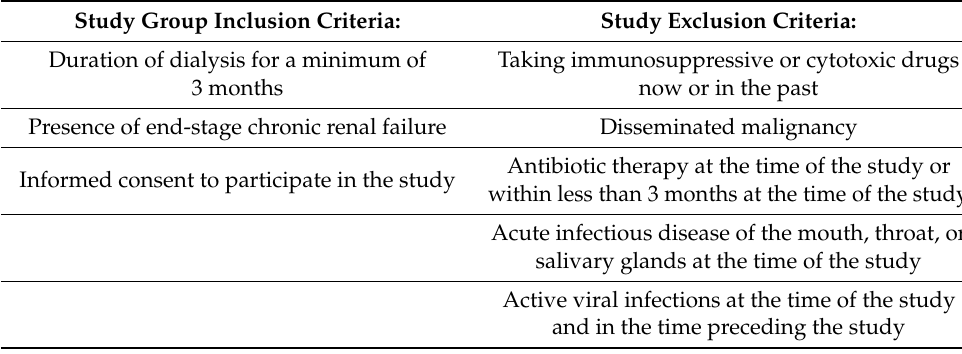
Table 1. Eligibility criteria for the study group